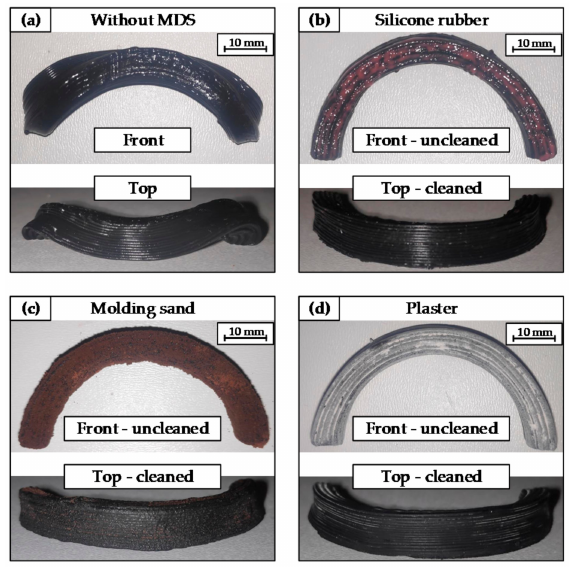
Figure 5. Vulcanized arc samples with the uncleaned front view and in the cleaned state with the top view: ( a ) without MDS, ( b ) silicone rubber, ( c ) molding sand, and ( d )